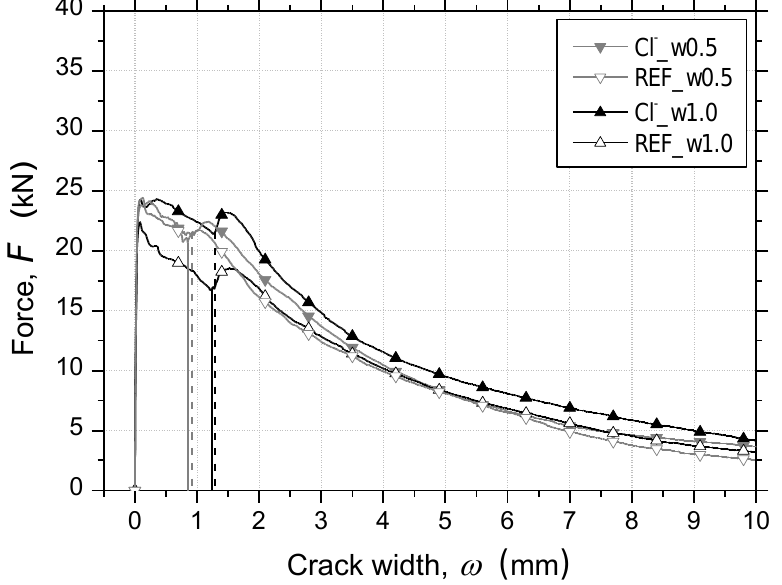
Figure 11. Average force–crack width ( F − ω ) relationships for panels from RPT-3ps after the exposure period of 90 days.